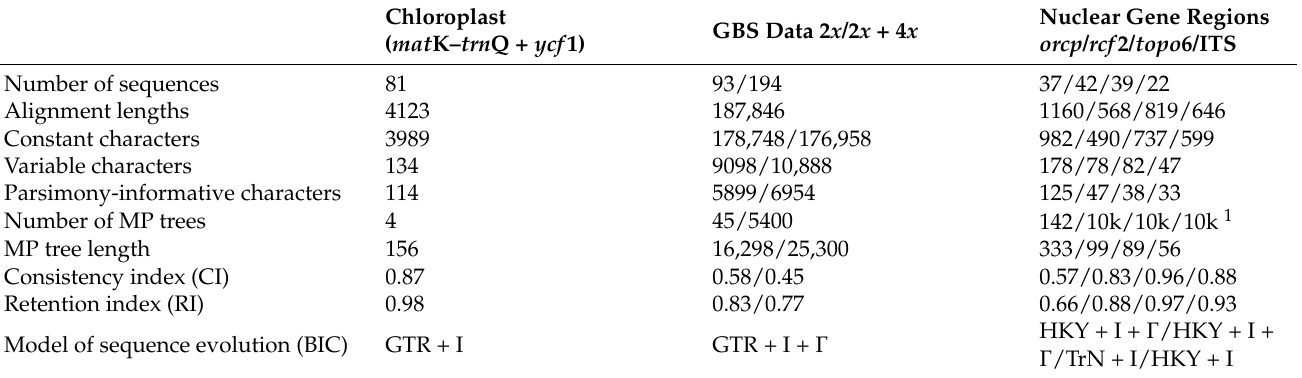
Table 2. Characteristics of the analyzed molecular datasets for Crocus ser. Verni .